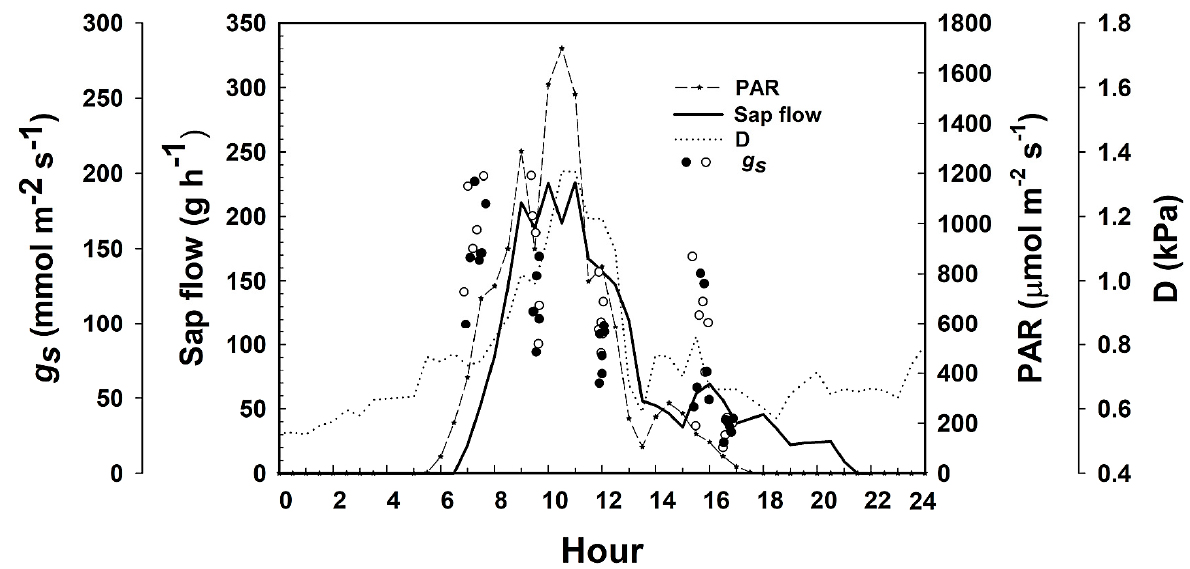
Figure 9. Example of a representative diurnal course of sap flow and stomatal conductance in relation to photosynthetically active radiation (PAR) and vapor pressure deficit (D) during the rainy season (29 October 2020) in a sun-grown coffee field in Costa Rica. Sap flow was measured in six coffee plants simultaneously; the average stem diameter was 28 mm and leaf area distal to the gauge was 2.5 m 2 . Stomatal conductance was measured during the day in sun and shade, for upper and lower leaves, in plants with (o) and without ( • ) sap flow gauges installed on their